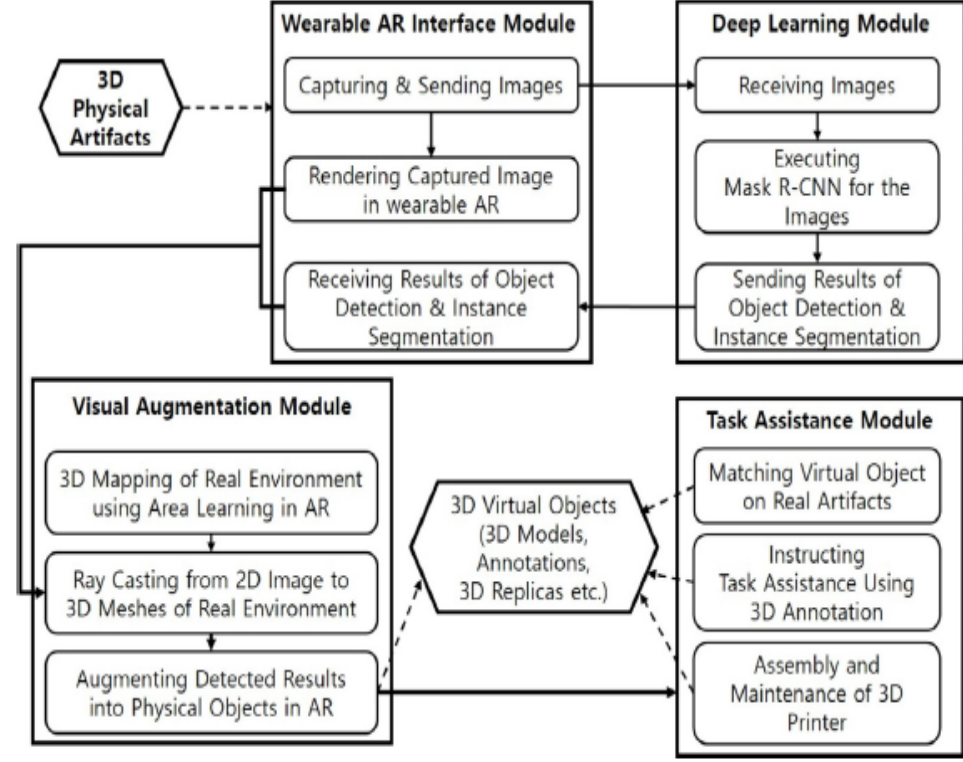
Figure 6. Architectural view of deep learning-based wearable AR (Park et al., 2020 [56]).